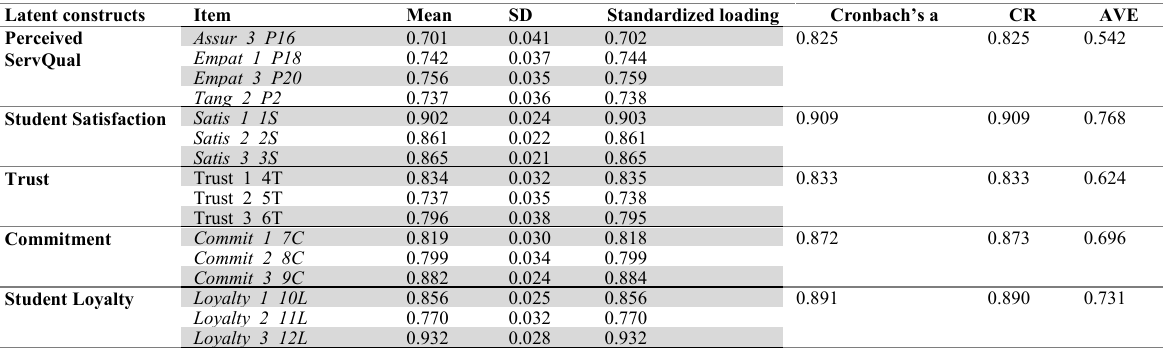
The Measurement model Latent